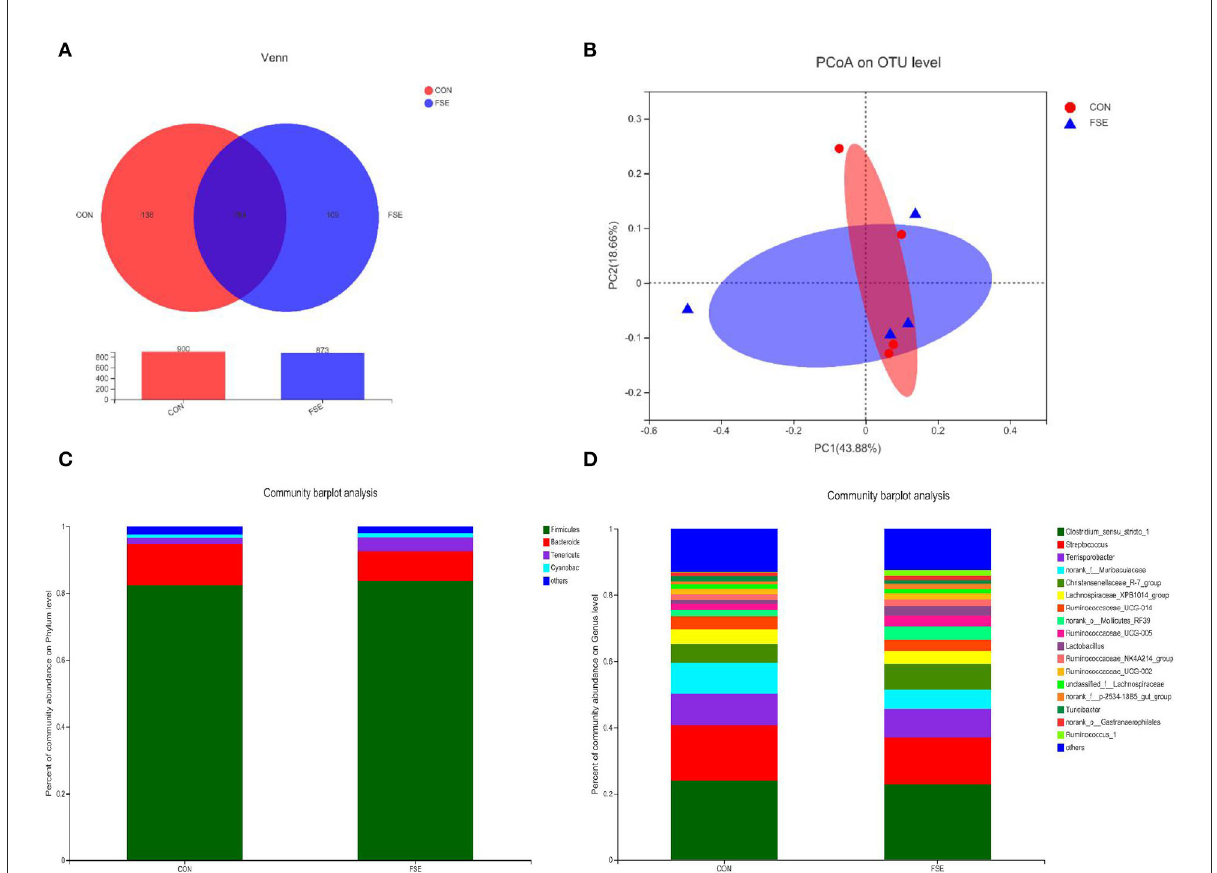
FIGURE2 The microbial community composition of colon digesta in finishing pigs supplemented with FSE (A) Venn diagrams of the bacterial operational taxonomic units (OUT) community among treatments; (B) PCoA on OUT level of microbial community among treatments; (C) Distribution of community barplot of microbial community at phylum level with the relative abundance higher than 0.01% among treatments; (D) Distribution of community barplot of microbial community at genus level with the relative abundance higher than 0.01% among treatments. CON: control; FSE: Forsythia suspensa extract. n =